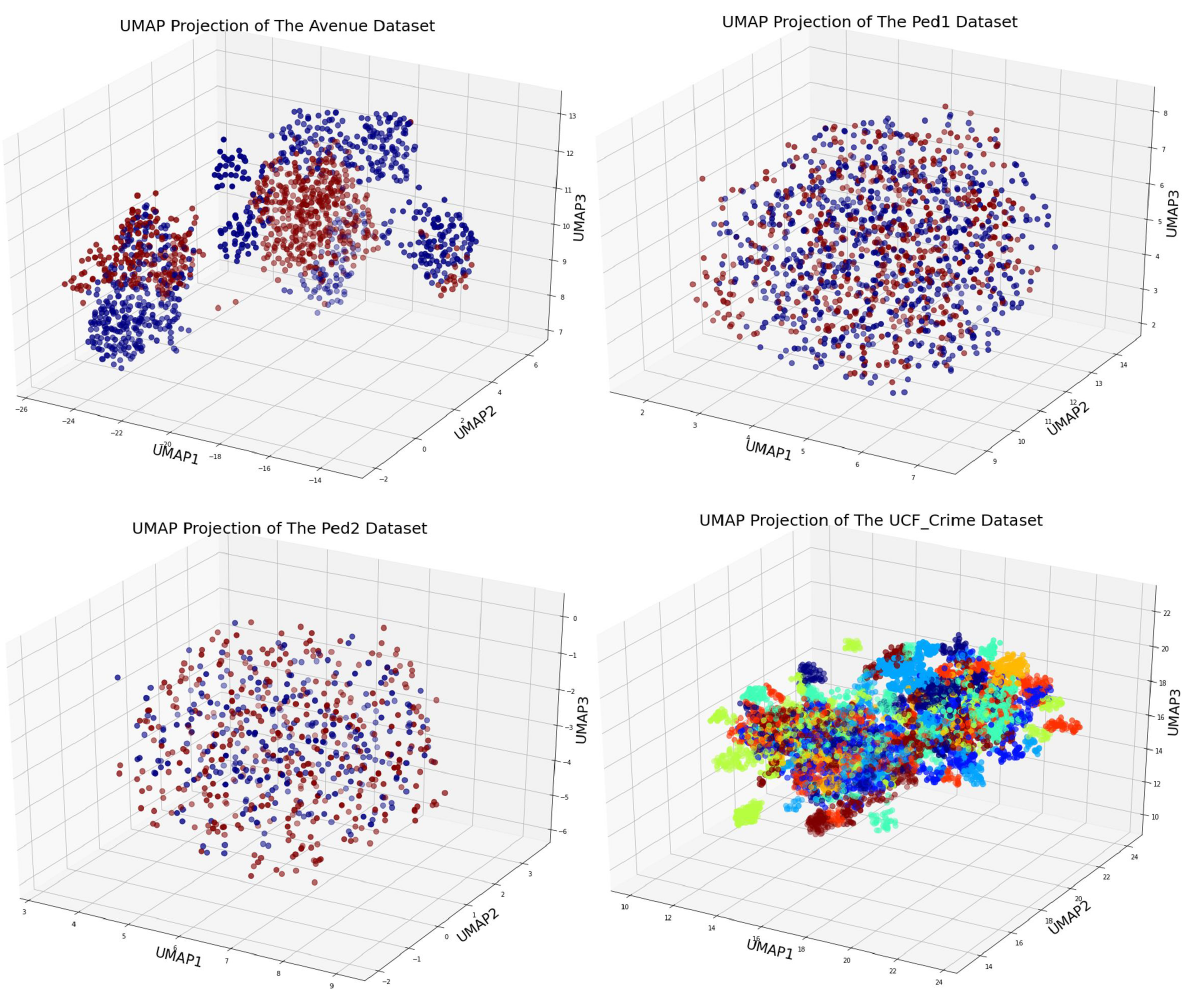
Figure 4. UMap data visualization of UCSD, CUHK, and UCF Crime